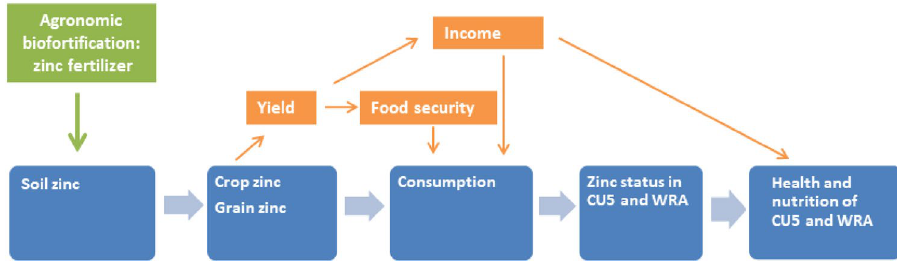
Figure 1. Conceptual framework of the potential impact of zinc agronomic biofortification of maize. (CU5: children under five years of age, WRA: women of reproductive